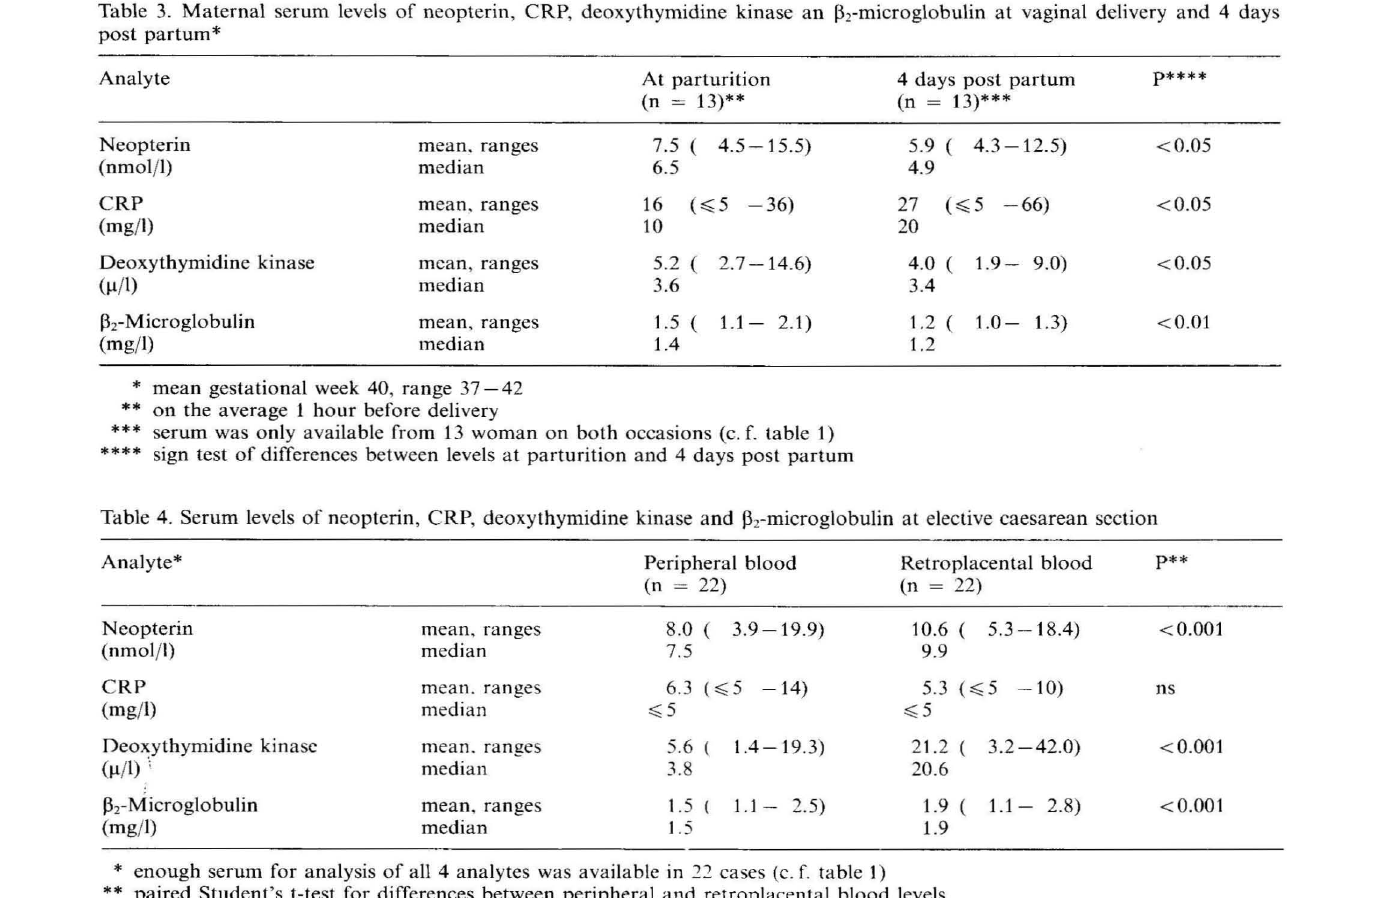
Table 5. Concentrations of neopterin, CRP, deoxythymidine kinase and ~,-microglobulin in mixed umbilical cord blood